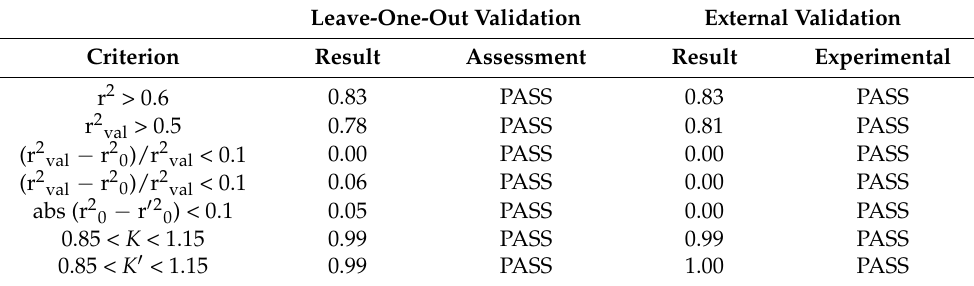
Table 3. Validation based on the Tropsha’s test for QSAR model 3.